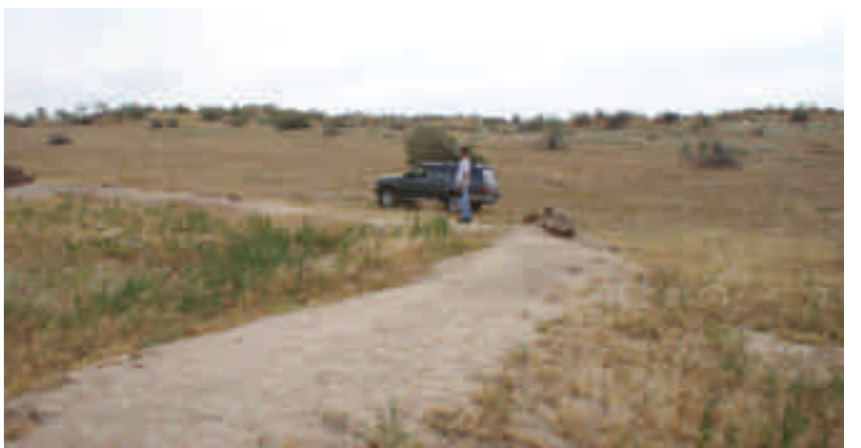
Figure 2 Gaigysyz Joraev and the desert survey vehicle, showing the scrub character of the desert area, just as the plants brought on by the brief spring rains are already beginning to dry out. In the foreground the low mounds show the lines of a heavily eroded caravanserai